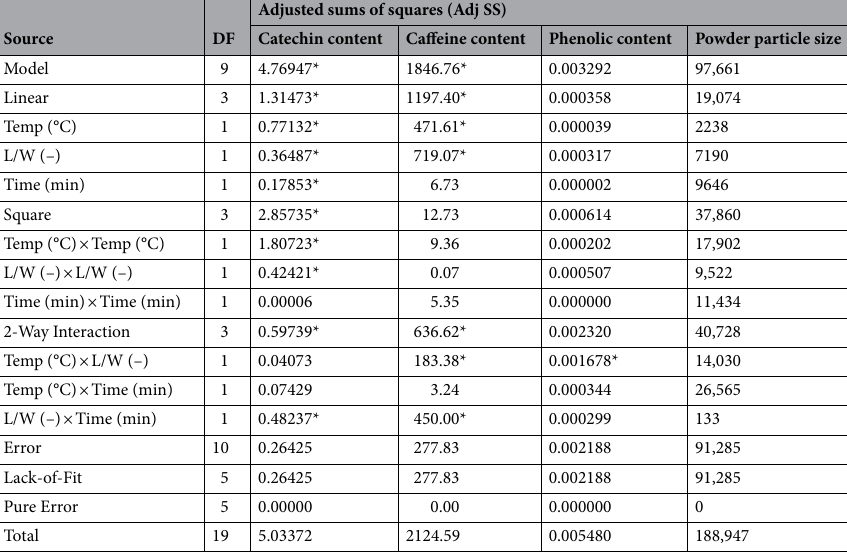
Table 3. Performance of variance analysis for catechin, caffeine, phenolic contents and powder particle size against temperature, leave-to-water and time of leaching conditions. DF Degree of freedom. * = < 0.05 of p value.